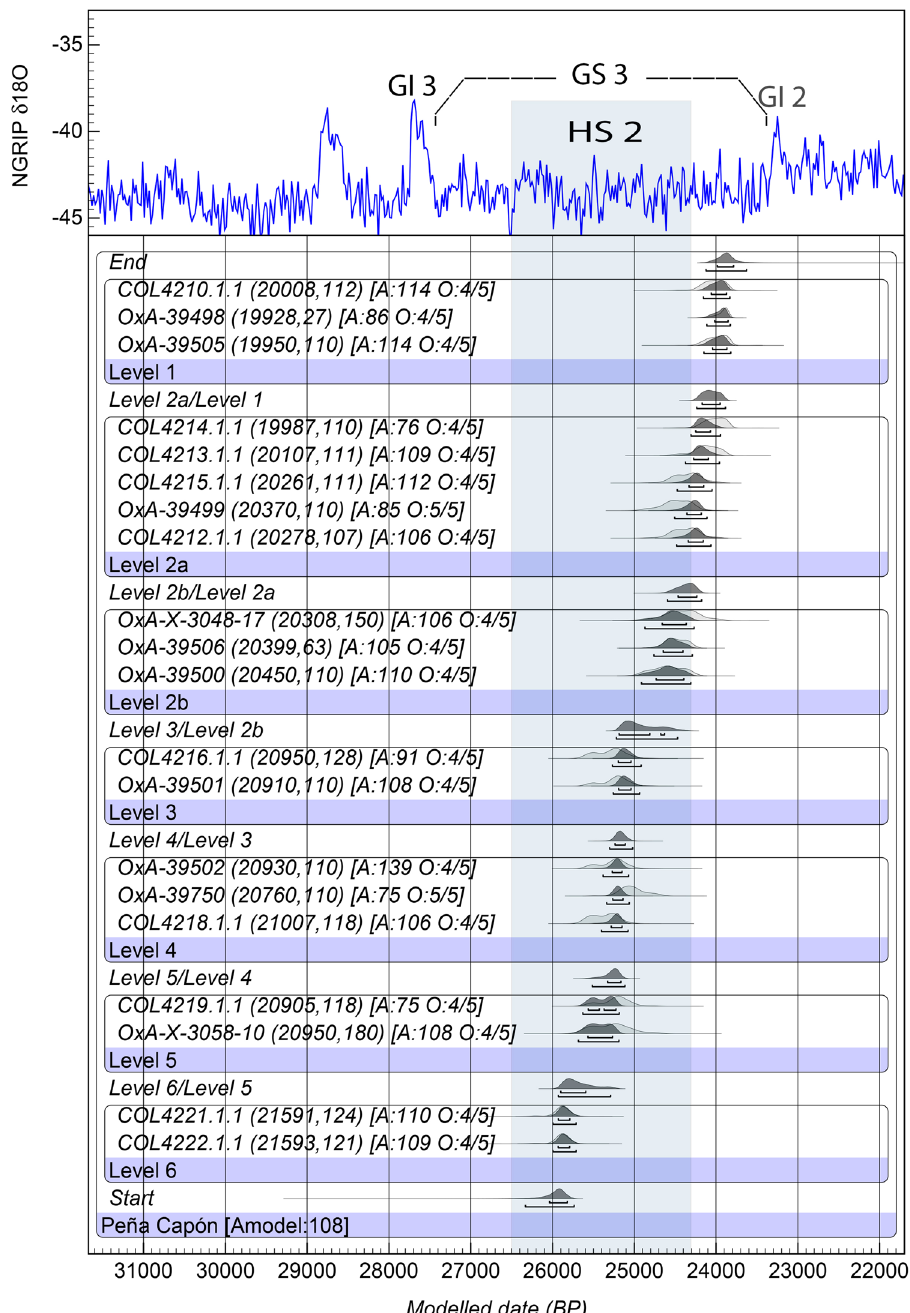
Figure 6. Bayesian Final Model (2) for the Peña Capón sequence showing Probability Distribution Functions (PDFs) for all radiocarbon determinations and boundaries between archaeological levels. Results are plotted against the δ18O record of the NGRIP ice core, indicating Greenland Interstadials 3 and 2 (GI 2 & GI 3), Greenland Stadial 3 (GS 3) 67 , and the chronology of Heinrich Stadial 2 (blue bar) 68 . 14C dates are shown in parentheses, and Agreement indexes and Outliers’ prior and posterior probabilities are shown in square brackets. Calibration of dates and Bayesian modeling were calculated using OxCal 4.4 online software (https:// c14. arch. ox. ac. uk/ oxcal.